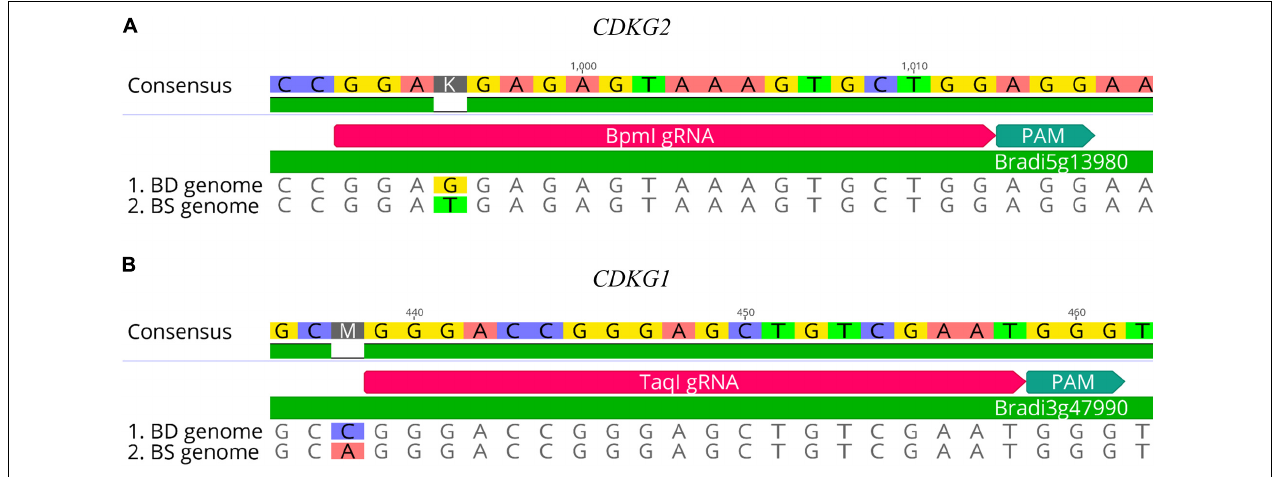
FIGURE 5 | Examples of gRNA sequences designed for targeted mutagenesis in B. hybridum. (A) SNP in the target sequence of Bd and Bs genomes located distal to the PAM. The gRNA was designed from the Bs genome sequence. (B) Example of SNP differentiating Bd and Bs genomes occurring outside the target 20-nucleotide